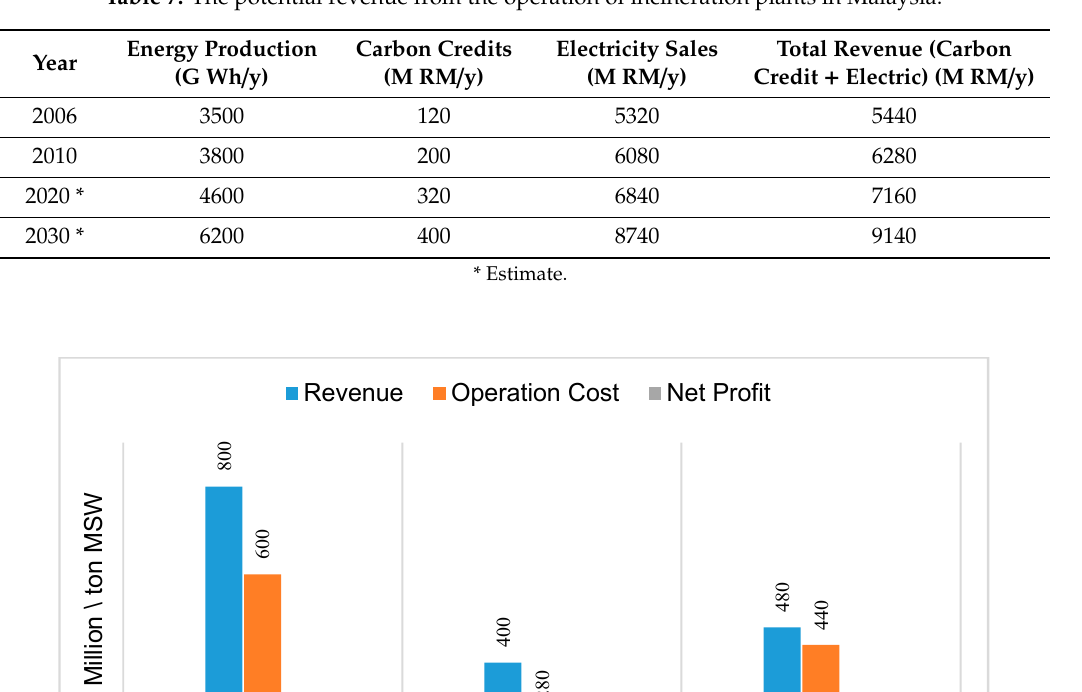
Table 7. The potential revenue from the operation of incineration plants in Malaysia.